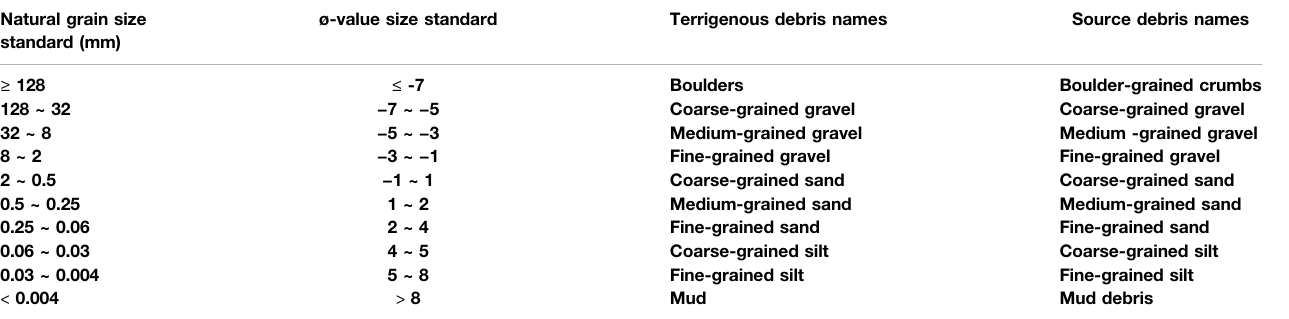
TABLE 1 | Correspondence between median grain size and ∅ -value size.